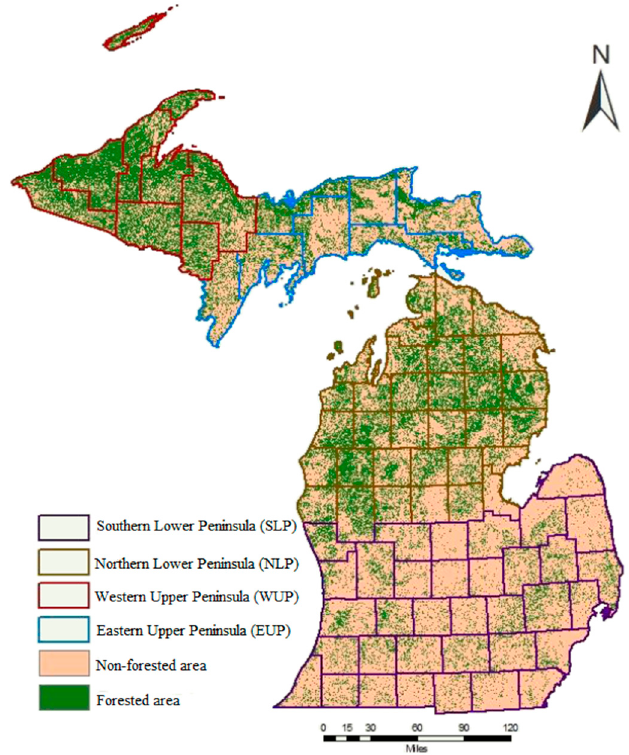
Figure 1. Michigan regions and forest (Based on study of [29]).